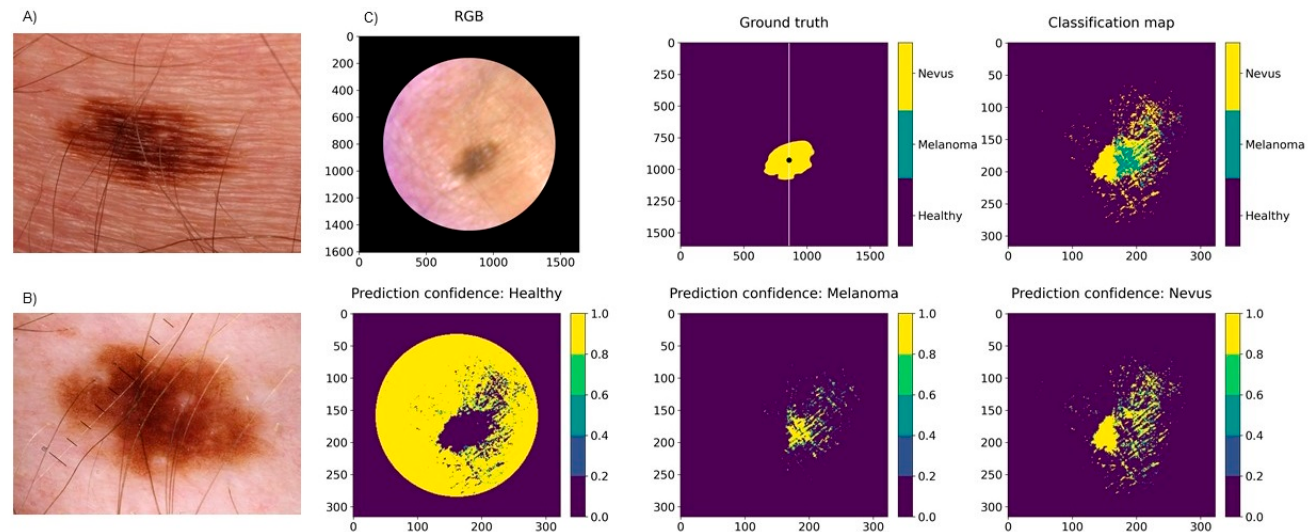
Figure 7. Clinical ( A ) and dermoscopy images ( B ) and a classification map ( C ) of a 10 mm low-grade dysplastic compound nevus of the chest, clinically and histologically diagnosed as a benign nevus but classified as a melanoma by the SICSURFIS system. The test data (right half of the image) included pixels classified as both melanoma and nevus. However, according to the majority voting analysis, there were more melanoma pixels. Light reflection caused probable artefacts in the surrounding area of the lesion.